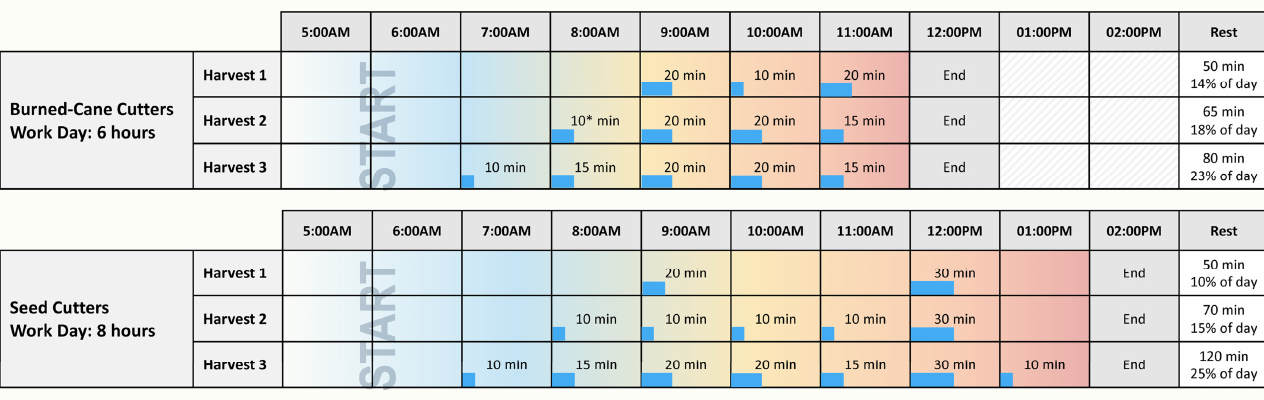
Figure 4. Rest schedule changes for burned and seed cane cutters: Existing (Harvest 1) and enhanced rest schedules observed (Harvest 2, Harvest 3), each providing more frequent and earlier rest periods. * Rest period at 08:00 a.m. in Harvest 2 was increased to 15 min for the last month of the harvest. Shade overview : In the absence of natural shade, additional shade tents were needed to avoid overcrowding in each. Furthermore, these needed to be light for easy movement throughout the day to keep close to the mobile workforce. Laborers needed to be provided with stools for comfortable rest and recovery (Figure